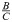
Schematic of three performance indicators: Effective Playing Space (EPS) which is the convex hull of the players (A), Player Length per Width (PLpW) (BC), determined as the ratio of team length B to team width C, and Team Separateness as the average distance between the attackers and their respective closest defender (D).